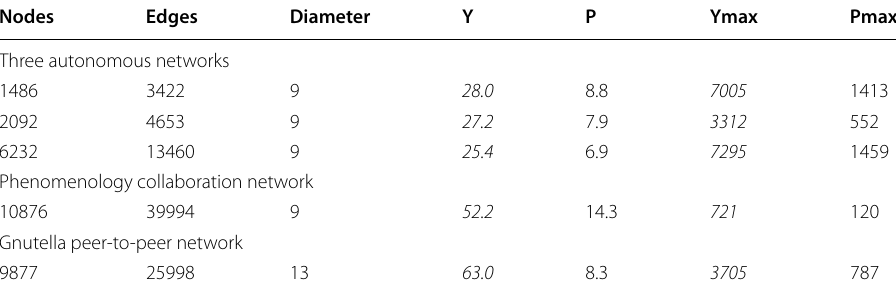
Y(Ymax) and P(Pmax) denote average(maximum) number of messages for the YTQ and pruning methods respectively